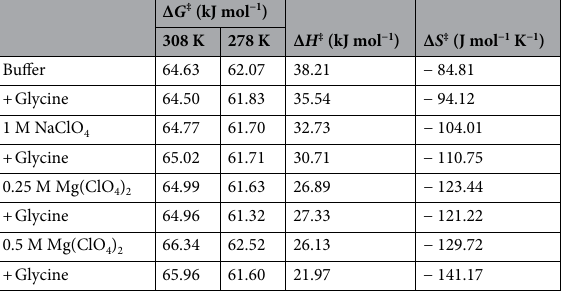
Table 2. α-Chymotrypsin thermodynamic parameters. The free energy of activation (Δ G ‡ ) at 308 K (35 °C) and 278 K (5 °C) and the enthalpy and entropy of activation (Δ H ‡ , Δ S ‡ ) in the presence and absence of perchlorate salts and 1 M glycine.